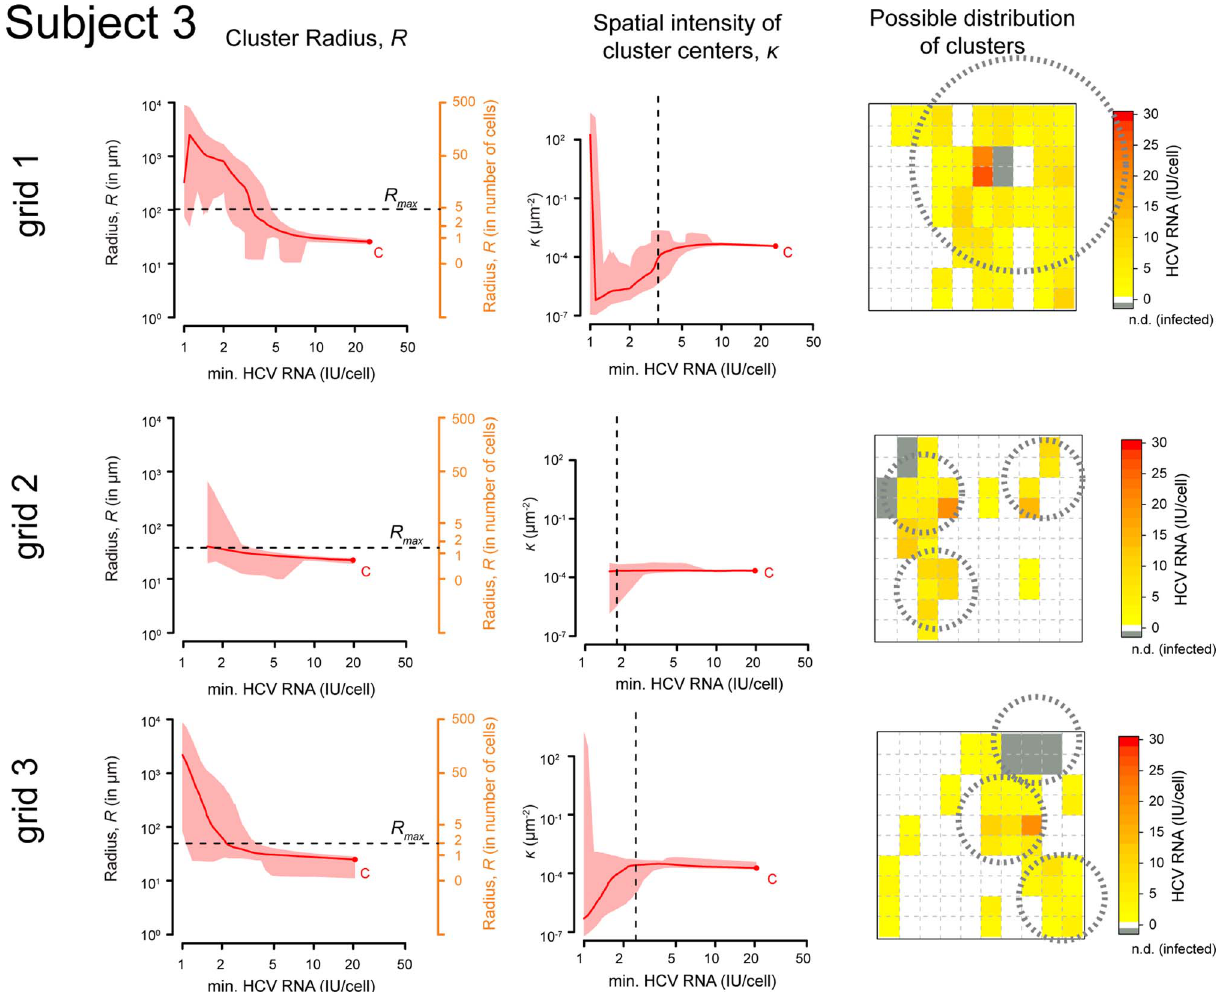
Figure 2. Estimates of domain radius and spatial intensity. Estimates of the domain radius R (left panel) and the spatial intensity k (middle panel) dependent on the minimal HCV RNA content of cells in the clusters for each of the three different grids on the sections of subject 3. Plots should be read from the right to the left as the algorithm starts at point C , the maximal amount of HCV RNA measured in an infected cell on the indicated grid. The domain radius of the cluster, R , is given on a continuous scale, as well as an estimate of the radius in number of cells. The red line is the median over 10,000 bootstrap replicates of fitting a Mate´rn cluster process to the data as described in Materials & Methods . The red area denotes the 95%-quantiles of the estimates. The dashed horizontal (left panels) and vertical (middle panels) lines indicate the cutoff of the algorithm, i.e., the maximal extension of the cluster, R max . The right panels show the observed spatial distribution of infected hepatocytes together with the measured HCV RNA amount. Grey squares indicate infected cells for which the actual HCV RNA amount could not be determined (n.d.). For the analysis, the HCV RNA amount of these cells was extrapolated according to different methods (see Materials & Methods ). Plots are combined with a possible distribution of the clusters showing for each the maximal cluster radius, R max (dashed circles). On grid 2 and 3, the estimated spatial intensity k is about 2 { 3 times higher than on grid 1, predicting the existence of several individual clusters on these sections.